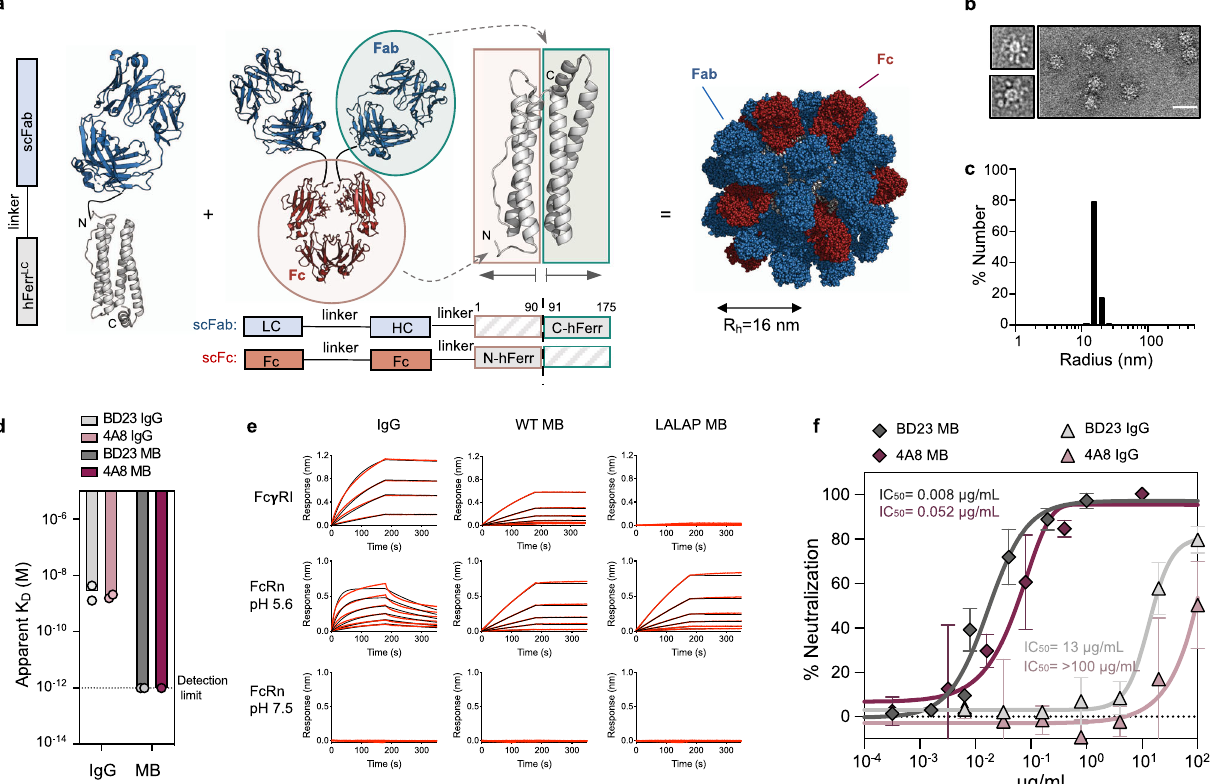
Fig. 3 Protein engineering to multimerize IgG-like particles against SARS-CoV-2. a Schematic representation of the human apoferritin split design. b Negative stain electron micrograph of the MB. (Scale bar 50 nm, representative of two independent experiments). c Hydrodynamic radius (Rh) of the MB. d Avidity effect on the binding (apparent K D ) of 4A8 (purple) and BD23 (gray) to the SARS-CoV-2 Spike. e Sensograms of BD23 IgG and MB with different Fc sequence variants binding to Fc γ RI (top row), FcRn at endosomal pH (middle row) and FcRn at physiological pH (bottom row). Red lines represent raw data whereas black lines represent global fi ts. f Neutralization of SARS-CoV-2 PsV by 4A8 and BD23 IgGs and MBs. Representative data of three biologically independent samples. The mean values± SD for two technical replicates is shown in each neutralization plot. Median IC 50 values of the three biologically independent replicates are indicated. Source data are provided as a Source Data fi